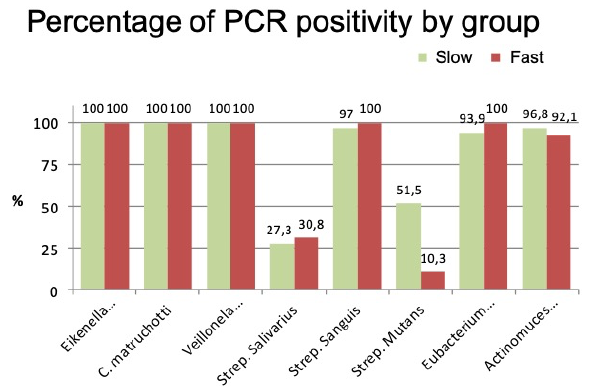
Figure 5. Percentage of bacteria analyzed in the groups of rapid and slow calculus formers.